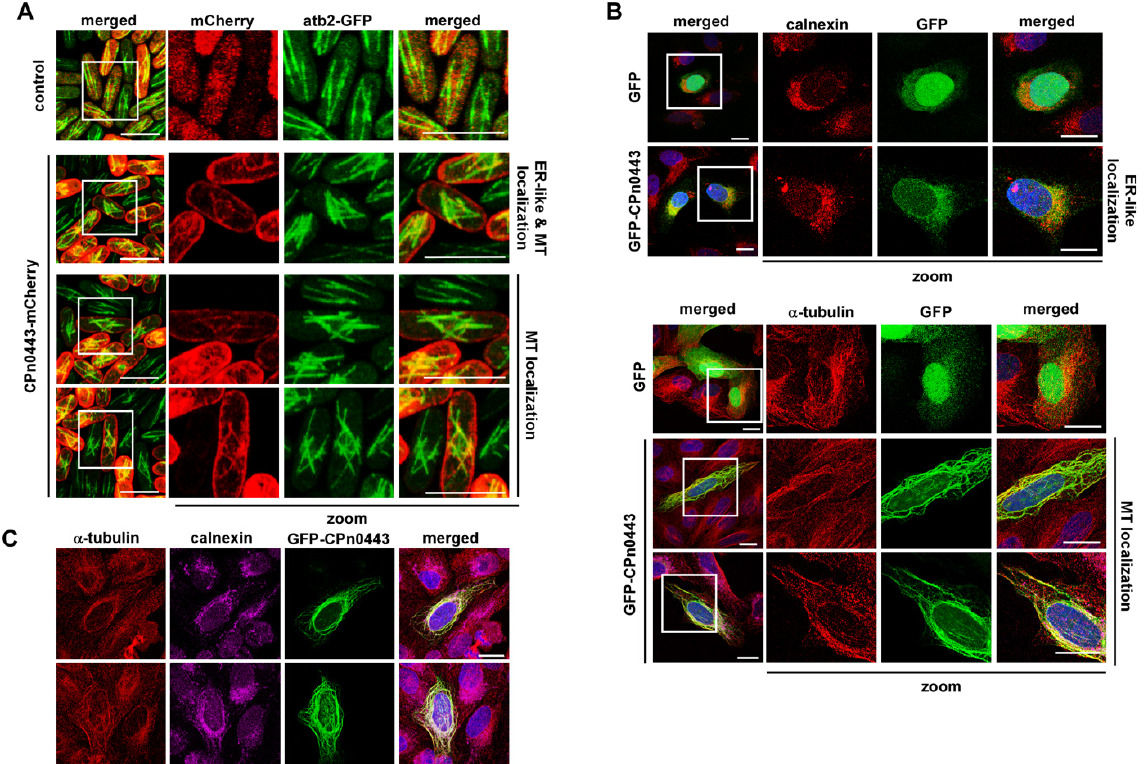
Figure 6. Ectopically expressed CPn0443 localized with the MT cytoskeleton and the ER. ( A ) Photo- micrographs of GFP- α -tubulin-expressing (green) S. pombe cells ( nmt81::GFP-atb2 + ). Cells were transformed with plasmids expressing mCherry (control) or CPn0443-mCherry. CPn0443-mCherry (red) co-localized with ER-like structures and partially with MTs (green). White boxes show the areas of enlargement; scale bar: 10 µm. Examples shown are representative cells from 3 independent experiments analyzing 50 cells/experiment. ( B ) Confocal images of fi xed human U2OS cells that expressed either gfp or gfp-cpn0443 . gfp-cpn0443 -expressing cells that showed an ER or MT co-local- ization. ER was visualized with the anti-calnexin antibody (red), MTs with the anti- α -tubulin anti- body (red), and DNA with DAPI (blue). White boxes show enlargement (zoom). The examples shown are representative of two independent experiments that analyzed 50 transfected cells/exper- iment. ( C ) Fluorescent microscopy images of fi xed U2OS cells that expressed gfp-cpn0433 showing co-localization with altered MTs and an altered ER. MTs were visualized with the anti- α -tubulin antibody (red), ER with the anti-calnexin antibody (magenta) and DNA with DAPI (blue). ( B , C) scale bars: 10 µm.